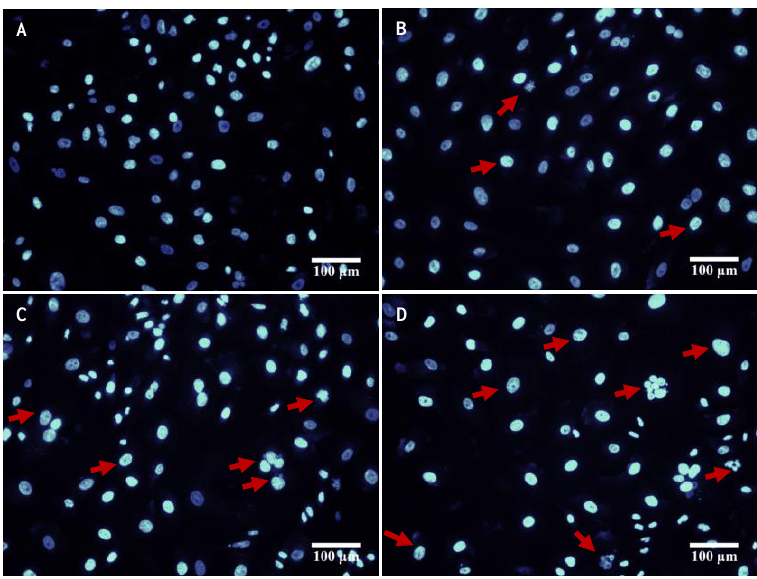
Figure 7. Illustrates DAPI stained fluorescent images of A549 cells ( A ) untreated and treated with ( B ) diosgenin only, ( C ) PGMD-DG 7:3, ( D ) PGMD-DG